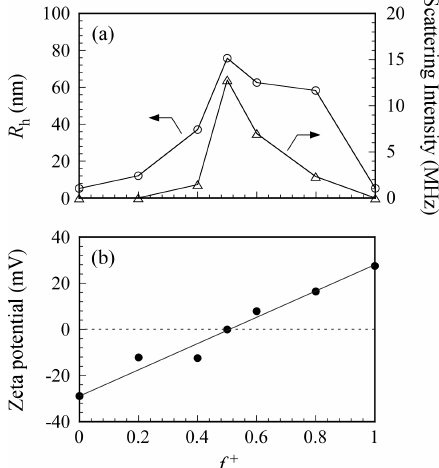
Figure 6. ( a ) Hydrodynamic radius ( R h , ○ ) and photon counting rate which indicates light scattering intensity ( △ ) for the PICsome composed of P 20 M 190 and P 20 A 196 as a function of f + (= [MAPTAC]/([MAPTAC] + [AMPS])) in 0.1 M NaCl; ( b ) ζ -potential for PICsome as a function of f + in 0.1 M NaCl. Total polymer concentration was fixed at 0.5 g/L.